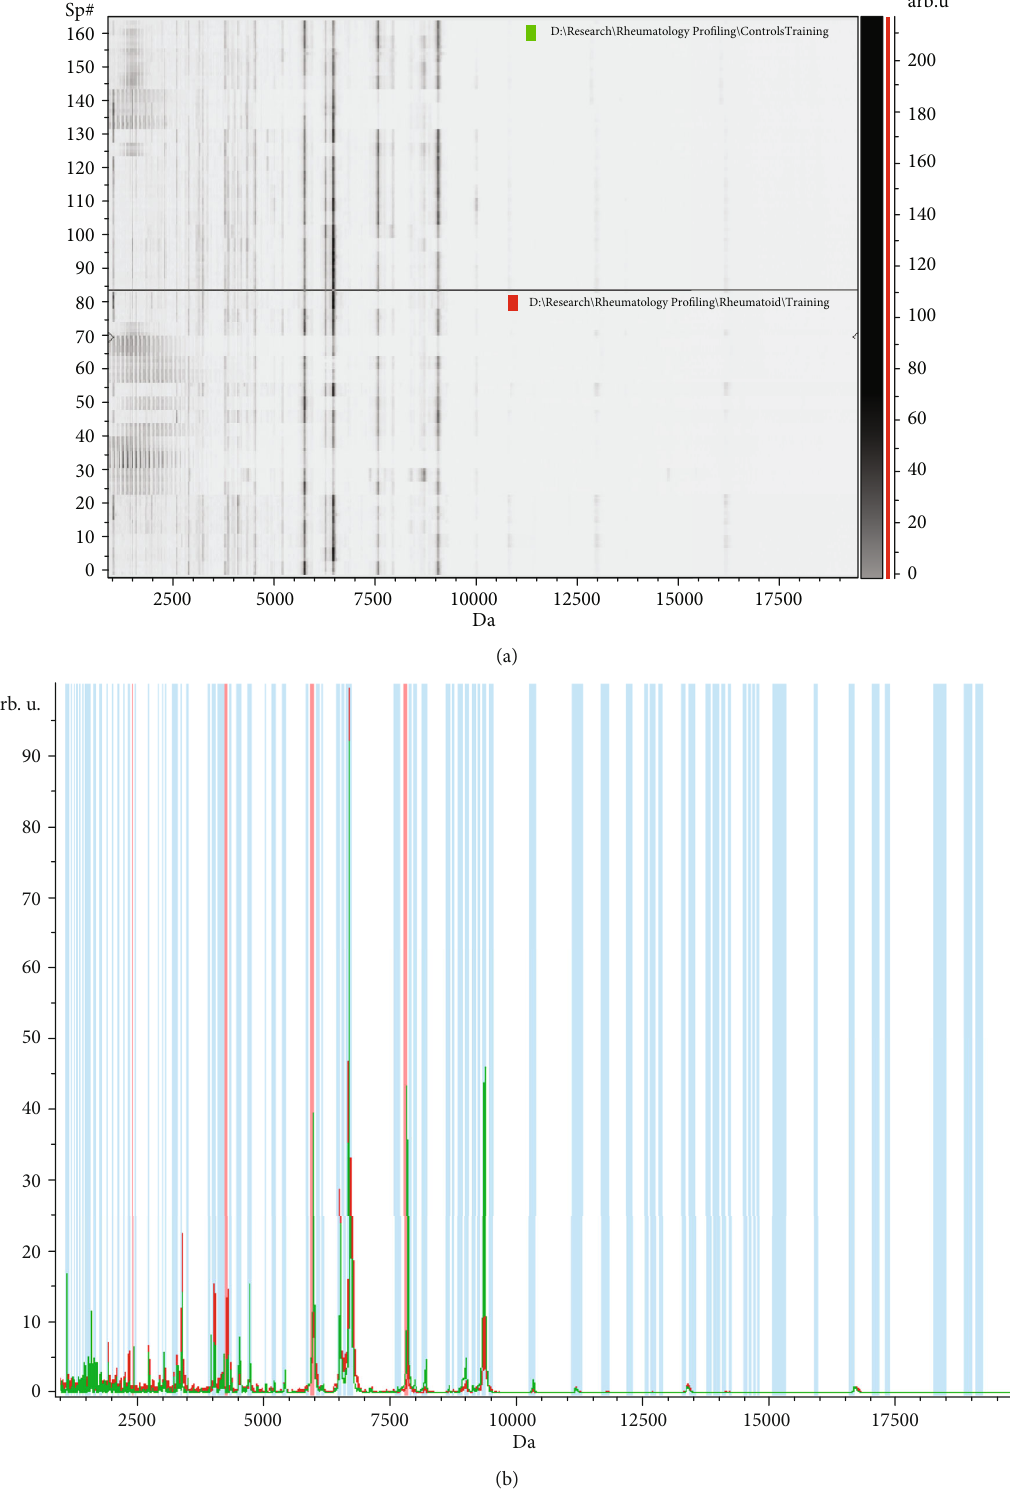
Figure 2: Peptidomic analysis of rheumatoid arthritis (RA) versus healthy control (HC) group. (a) The pseudogel view using ClinPro Tools. The RA group at the bottom and HC at the top. Each peak is represented by a vertical line. The di ff erence in intensity between the lines represents the di ff erential peak expression between the two groups. (b) The whole spectral view in ClinPro Tools. The fi gure represents the RA group in red against HC in green. Peaks included are demarcated with vertical blue lines. Peaks demarcated with red vertical lines are the integration